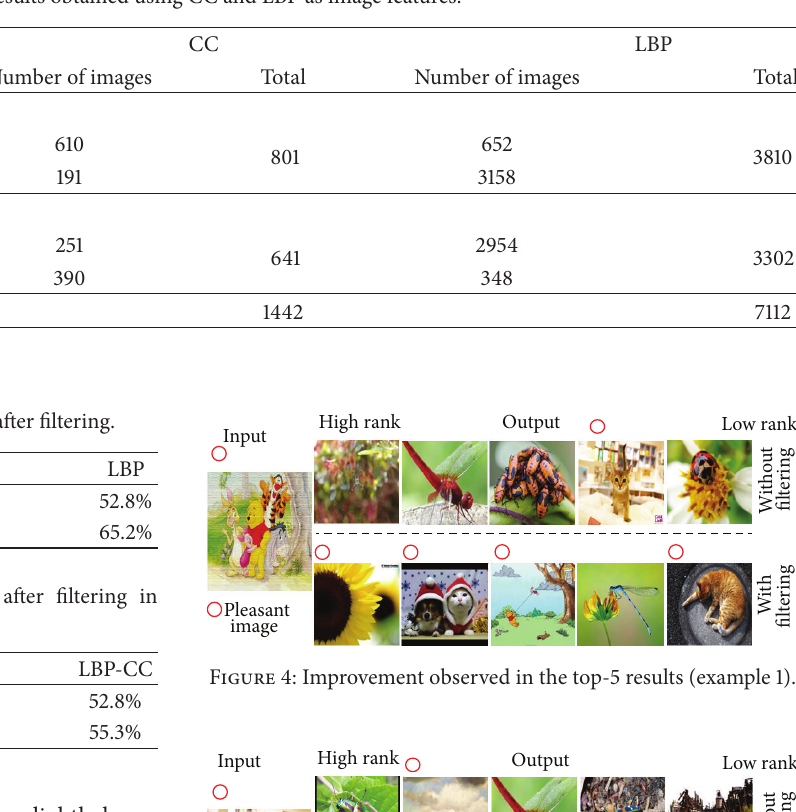
Table 2: Results obtained using CC and LBP as image features.